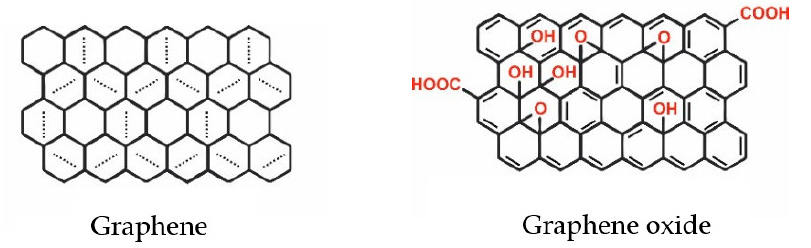
Figure 2. Structure of graphene and graphene oxide.